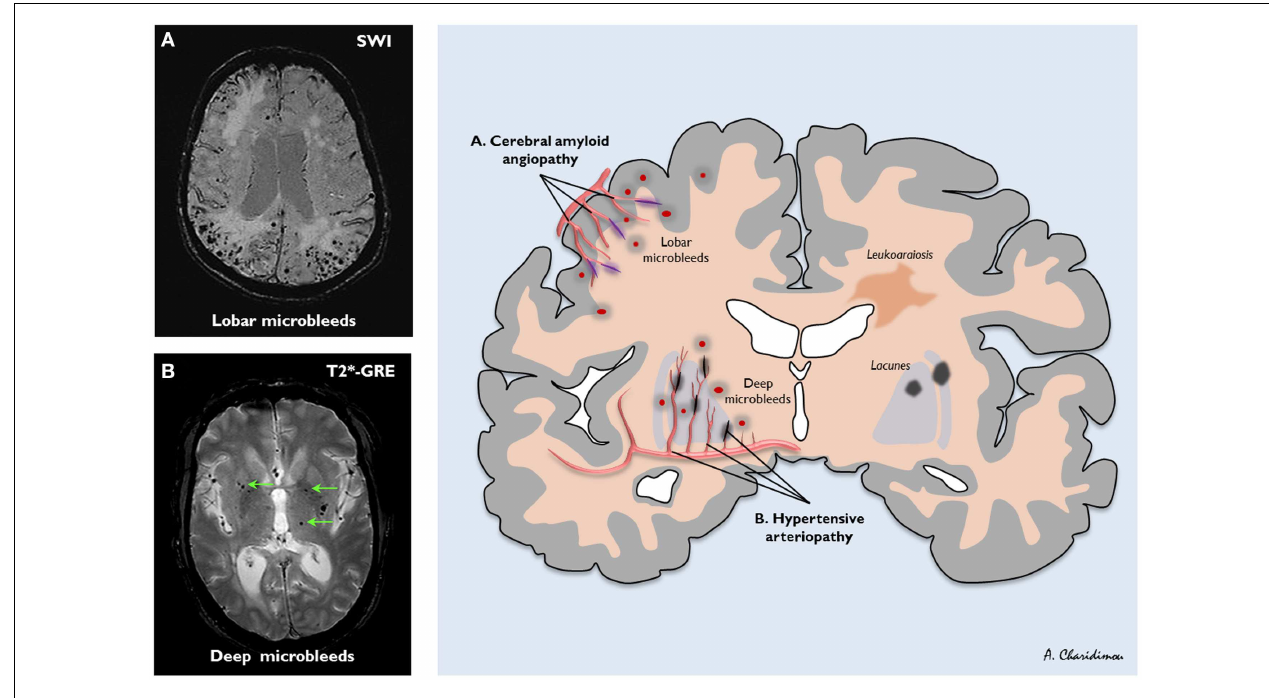
anatomic distribution is meant to reflect the underlying pathological vessel damage. Hence, CMBs (dark, rounded lesions) located in cortical-subcortical regions are presumably caused by CAA (A) , whereas CMBs located in deep brain regions mainly result from hypertensive arteriopathy (B) . (A) is an axial susceptibility-weighted imaging (SWI) which is currently the most sensitive means to image CMBs. (B) is an axial T2*-weighted gradient-recalled echo (T2*-GRE)